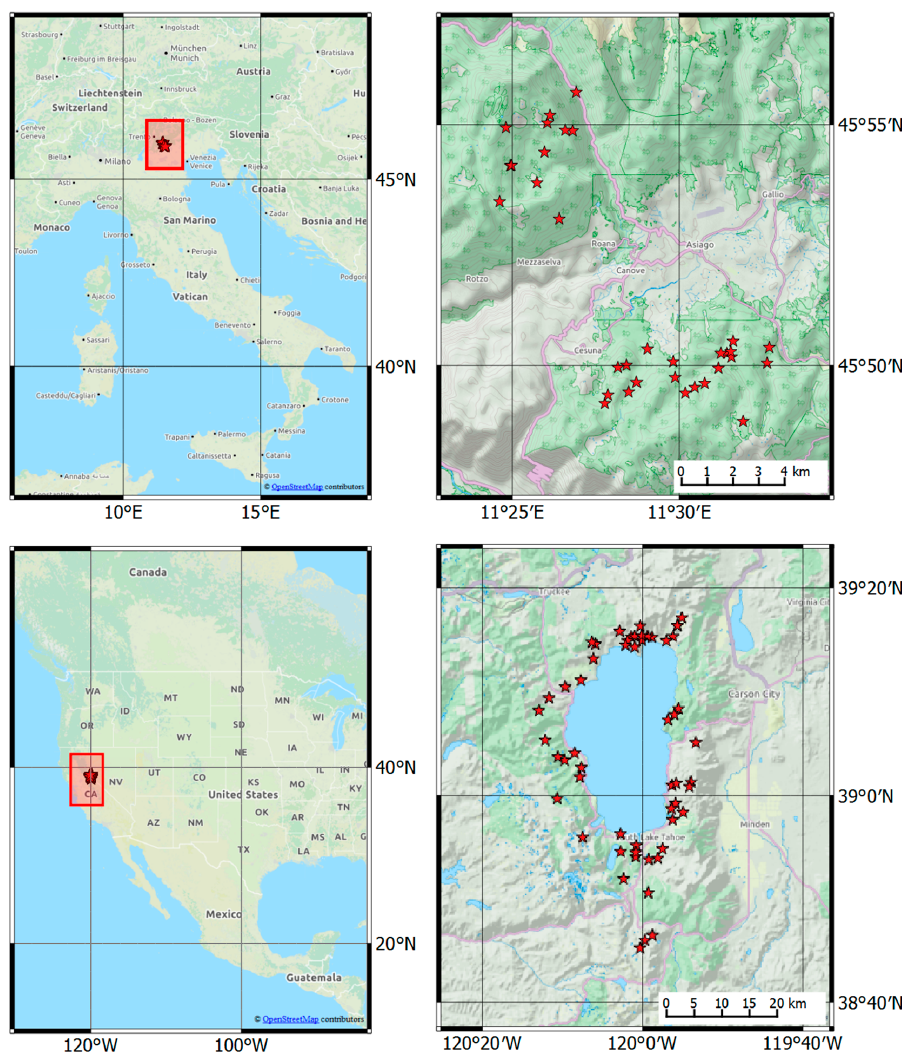
Figure 1. The Asiago ( top ) and Tahoe ( bottom ) study sites. On the left side, the geographic location of the areas are illustrated; on the right side a zoom over the area is shown, with red star symbols indicating field plots.